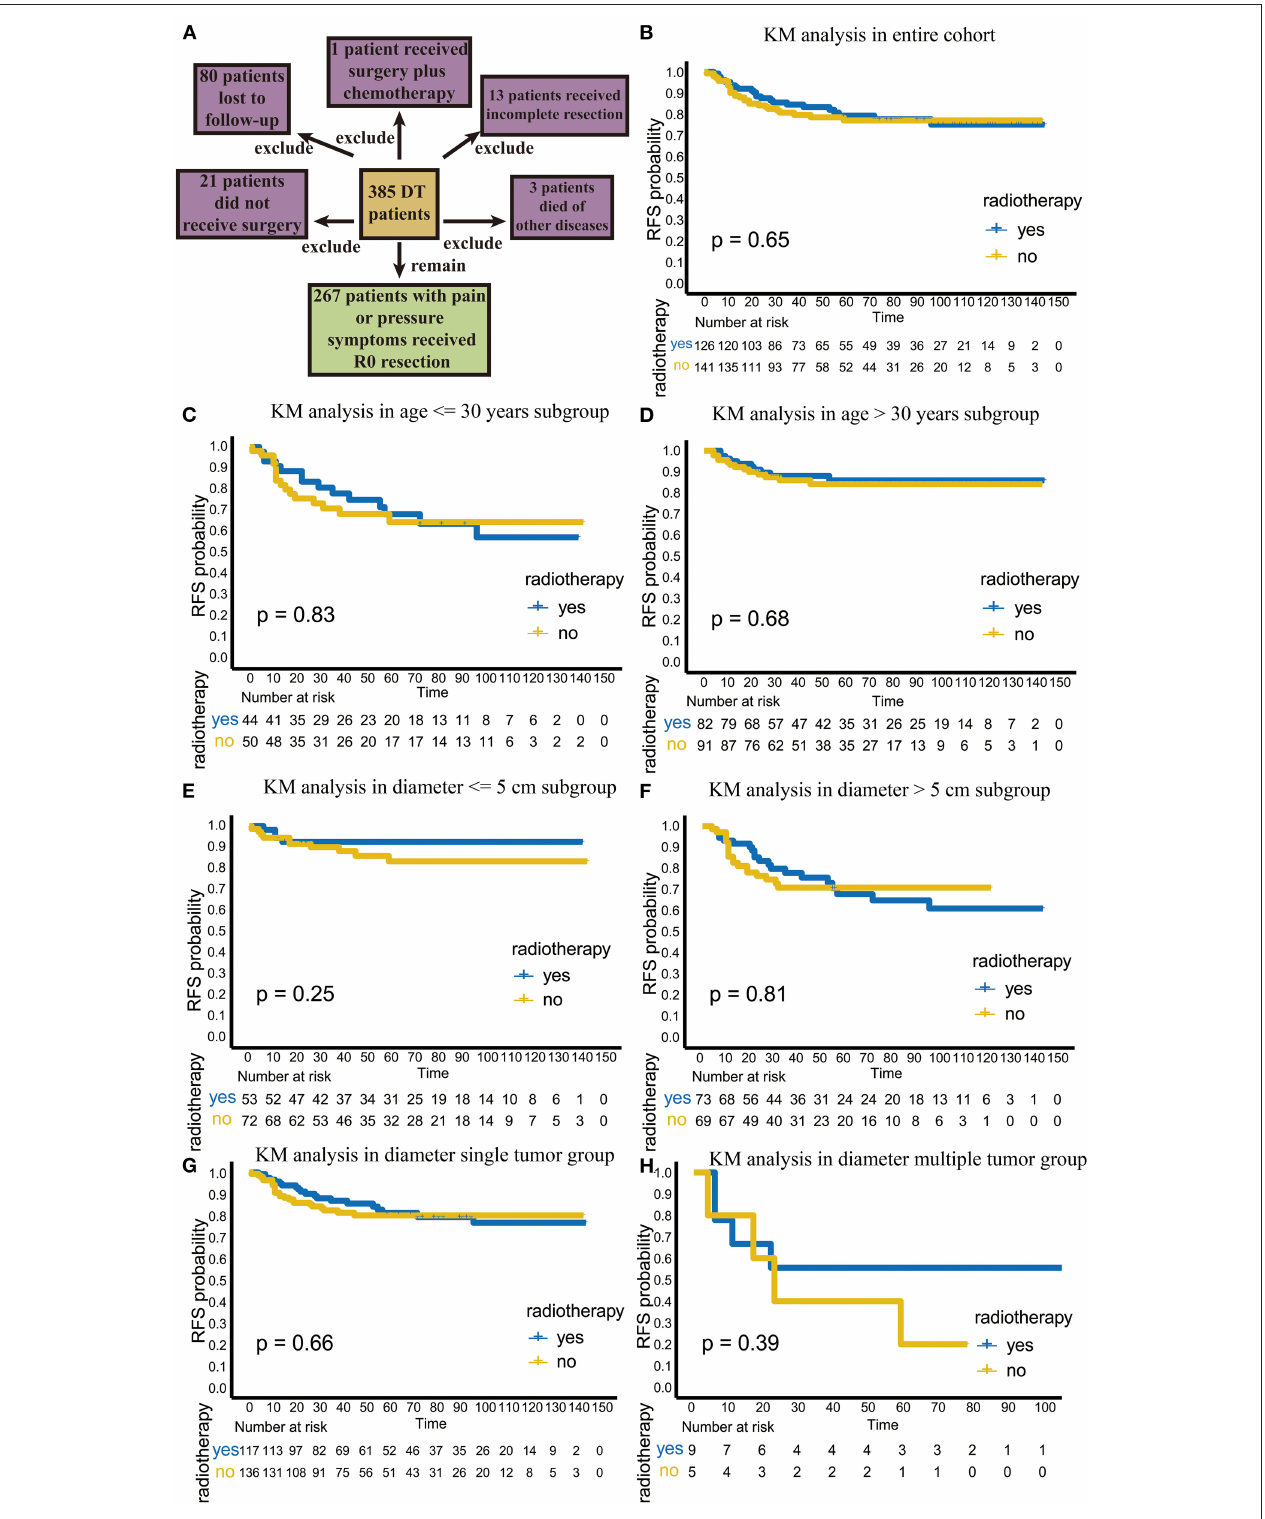
FIGURE 1 | The flowchart of patient selection and efficacy analysis of radiotherapy in the entire cohort and different subgroups. (A) The flowchart of patients selection. (B) The efficacy of radiotherapy in entire cohort. (C) The efficacy of radiotherapy in the age ≤ 30 years old subgroup. (D) The efficacy of radiotherapy in the age > 30 years old subgroup. (E) The efficacy of radiotherapy in the diameter ≤ 5cm subgroup. (F) The efficacy of radiotherapy in the > 5cm diameter subgroup. (G) The efficacy of radiotherapy in the single-tumor subgroup. (H) The efficacy of radiotherapy in the multiple-tumor subgroup.